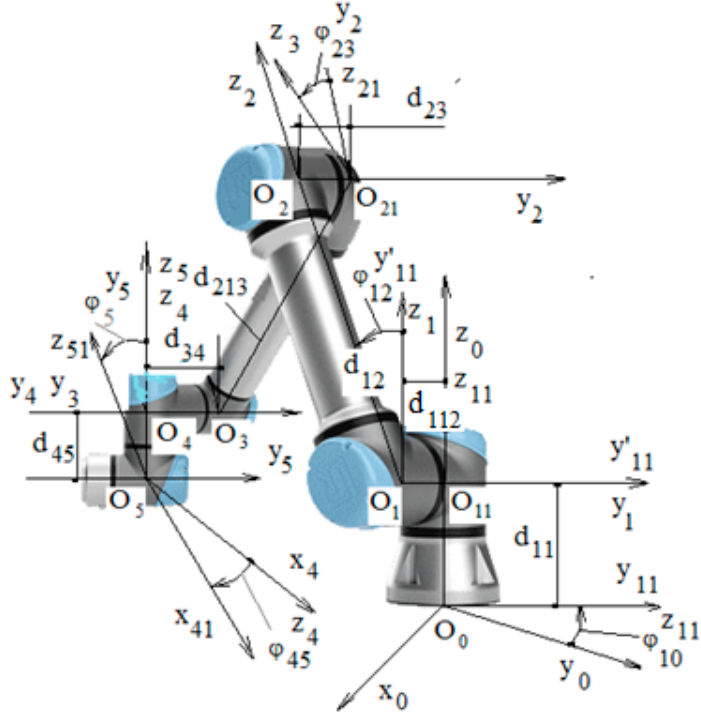
Figure 8. The necessary notations for solving the direct kinematics with the method of homogeneous